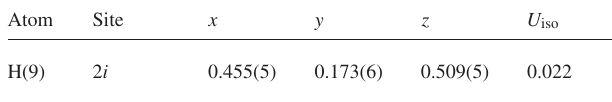
Table 2. Atomic coordinates and displacement parameters (in Å 2 )